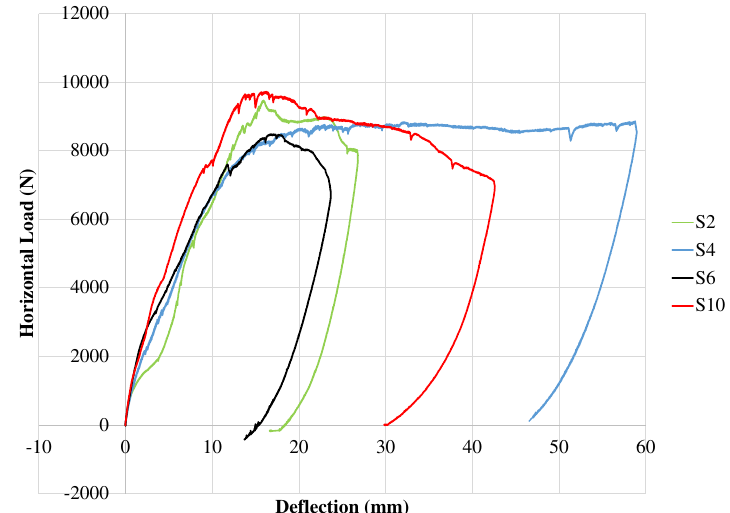
Fig. 10 Load deflection curve for specimens: S2, S4, S6, and